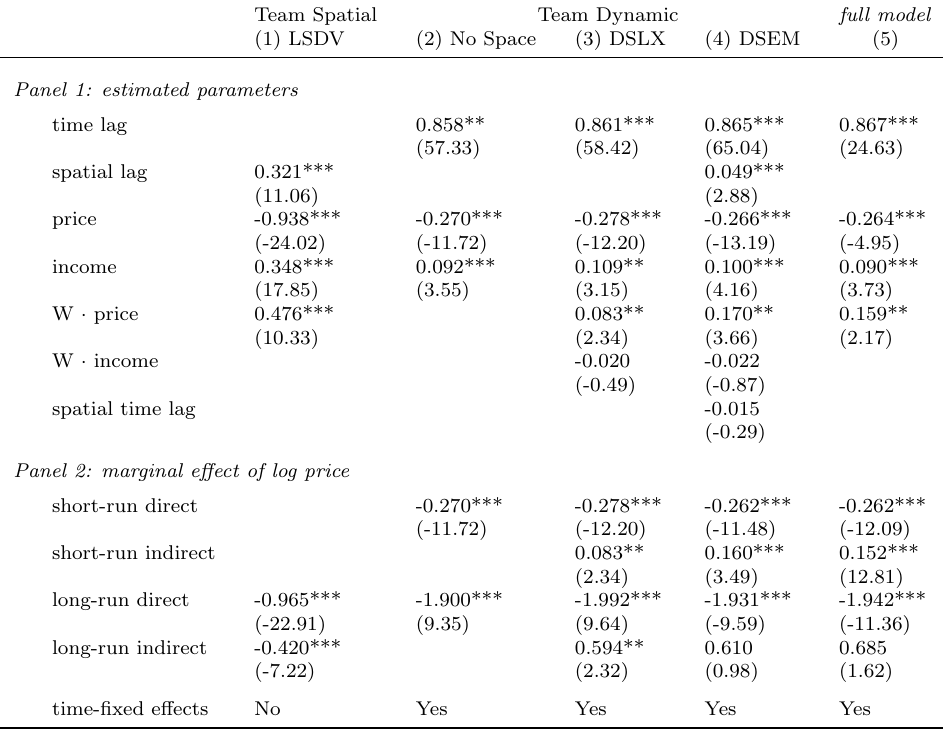
Table C.1: Empirical illustration – Alternative specifications; dependent variable: log